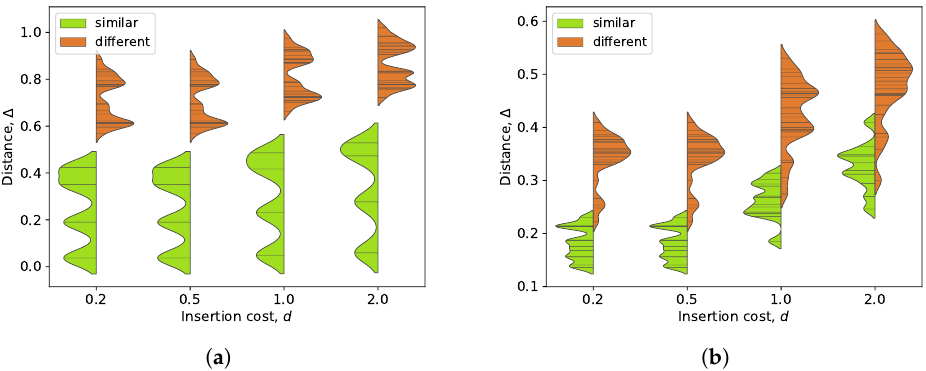
Figure 7. Distribution of distance ∆ calculated for two benchmarks using various values of insertion cost d : ( a ) benchmark composed of OTAs; ( b ) benchmark composed of NAND and OR gates.